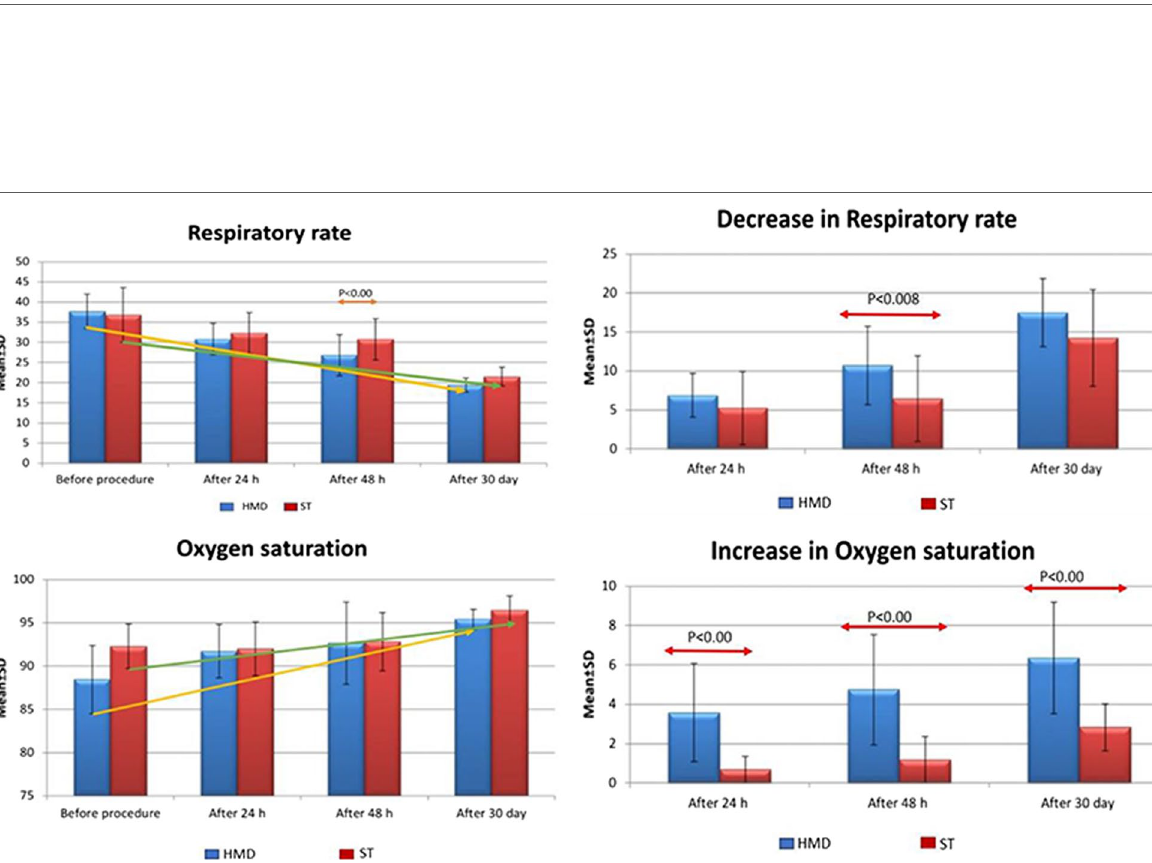
Fig. 3 Rate of change in systolic blood pressure and pulmonary artery systolic pressure between study groups at admission and during follow‑up